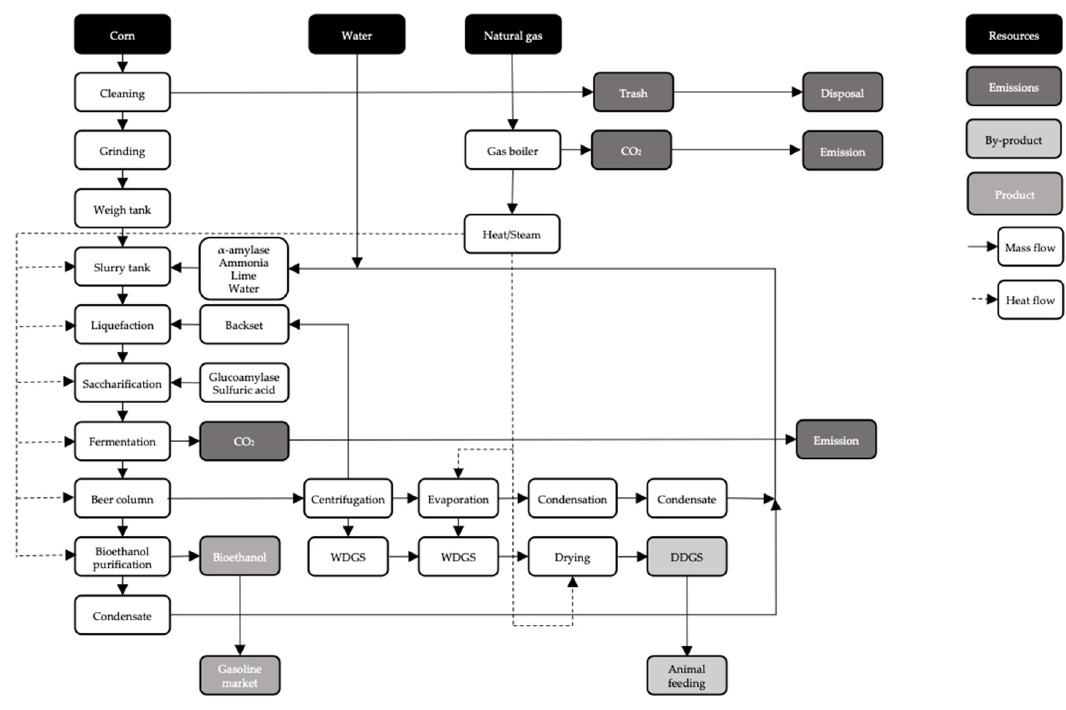
Figure 3. A detailed breakdown of the processes in a conventional ethanol plant.